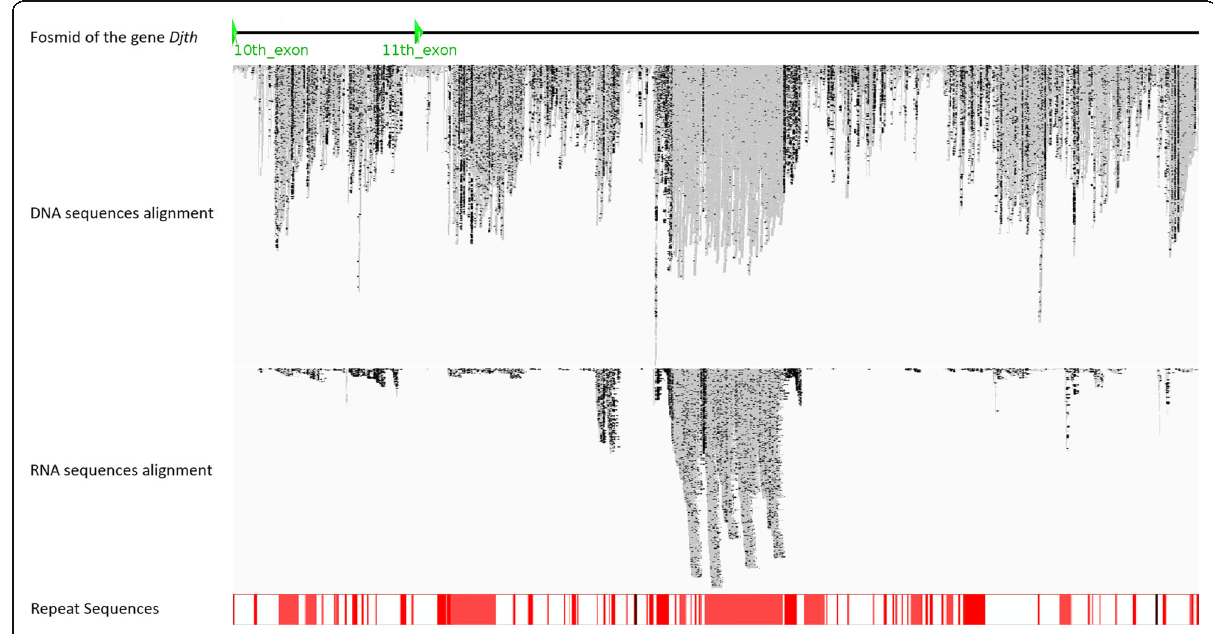
Fig. 2 One fosmid insert sequence of the gene Djth (DJF-016O13). This figure shows the alignment of genomic DNA and RNA sequencing reads to one fosmid insert sequence of the gene Djth (DJF-016O13) and the repeated elements annotation of this fosmid sequence by Repbase. Green arrowheads show the10th and 11th exon of the Djth gene on the fosmid insert sequence. Grey spots show matches between the sequencing reads and the reference fosmid sequence, and black spots show mismatches. Red bars represent repetitive